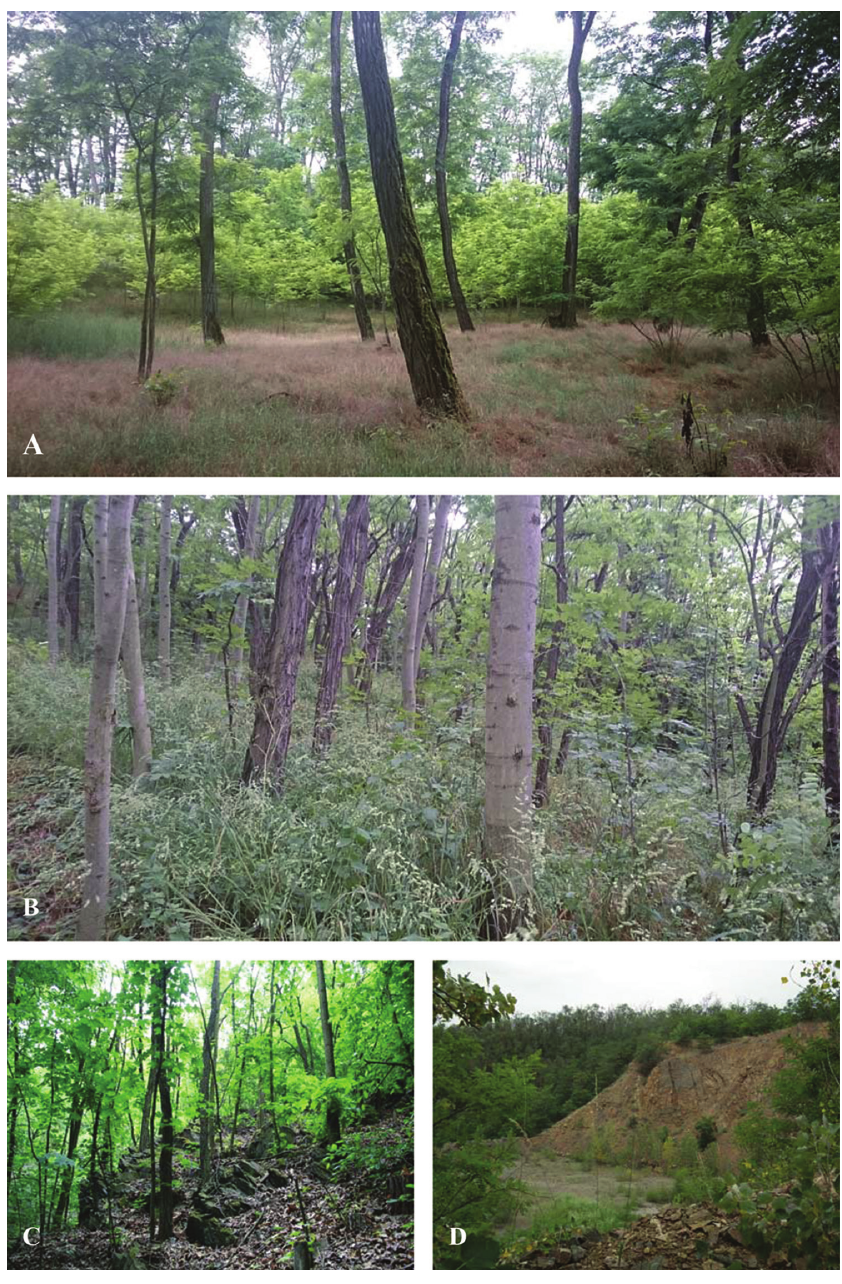
Figure 3. Closed forests in natural habitats ( A–C ) and small-scale stands in man-made habitats ( D ). A Robinia forest regenerating and managed by coppicing in stripes B Planted mixed forest with native Fraxinus excelsior and alien Robinia pseudoacacia C Old Robinia forest overgrown by Fraxinus excelsior and Acer platanoides as a result of spontaneous succession D A spontaneously established mixed stand with Robinia growing in a